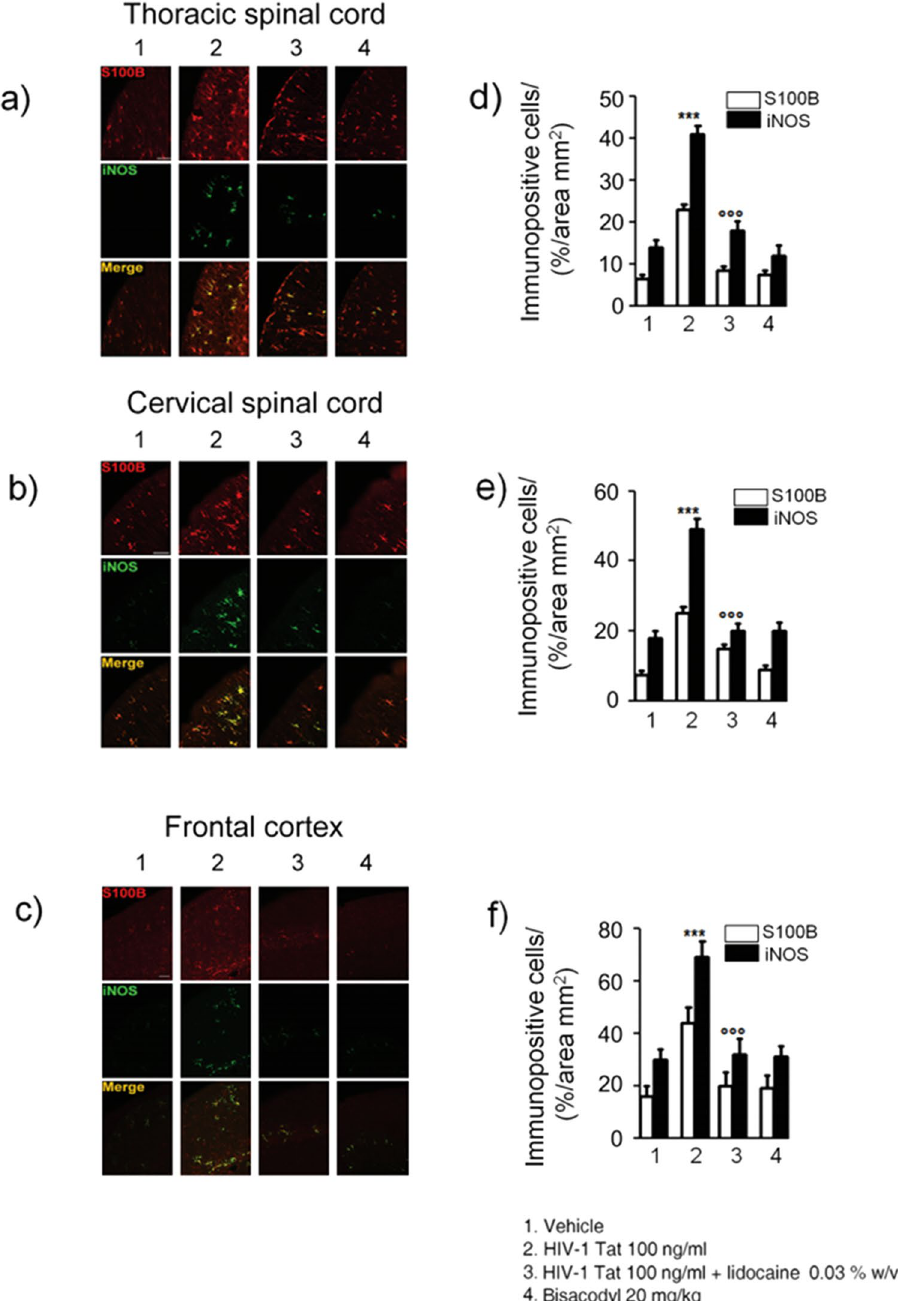
Figure 6. Intracolonic administration of HIV-1 Tat induced glial activation in the ( a ) thoracic and ( b ) cervical spinal cord and ( c ) frontal cortex at day 12, 14 and 21 after diarrhea induction, respectively. ( a – c ) Immunofluorescence analysis showed that iNOS (green) and S100B (red) co-expression was increased in the spinal cord and frontal of HIV-1 Tat treated rats. ( d – f ) Quantitative analysis showed that HIV-1 Tat-induced upregulation of iNOS (filled bars) and S100B (open bars) was significantly inhibited by lidocaine treatment. Results are expressed as mean ± SEM; *** p < 0.001 vs all other groups; °°°p < 0.001 vs HIV-1 Tat group. Scale bars: 100 μ m; n = 6 for each